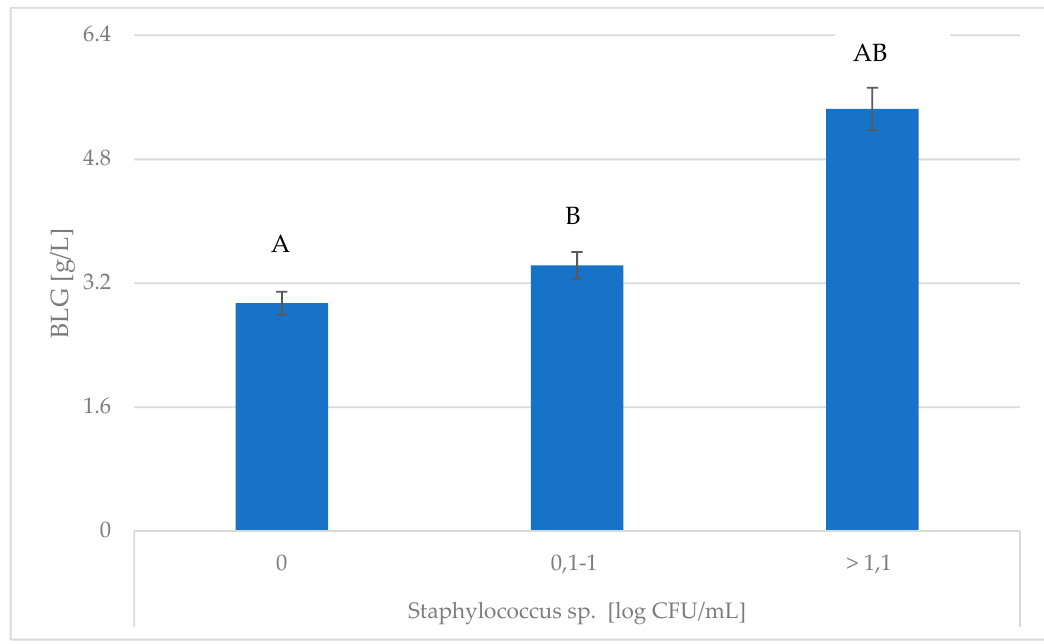
Figure 3. Association of Staphylococcus spp . with changes in BLG content. BLG— β -lactoglobulin; A,B Means with the same letters differ significantly at: capitals— p ≤ 0.01.